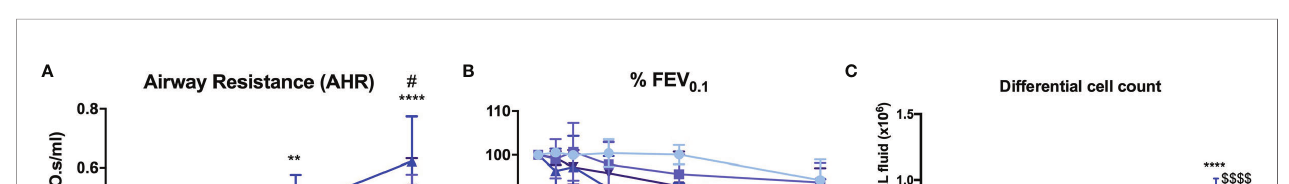
depletion ( Supplementary Table 7 ). No signi fi cant differences in lung ILC proportions were found between LPS-exposed isotype-injected mice compared to LPS-exposed anti-Ly6G- injected mice ( Supplementary Figure 9 ).